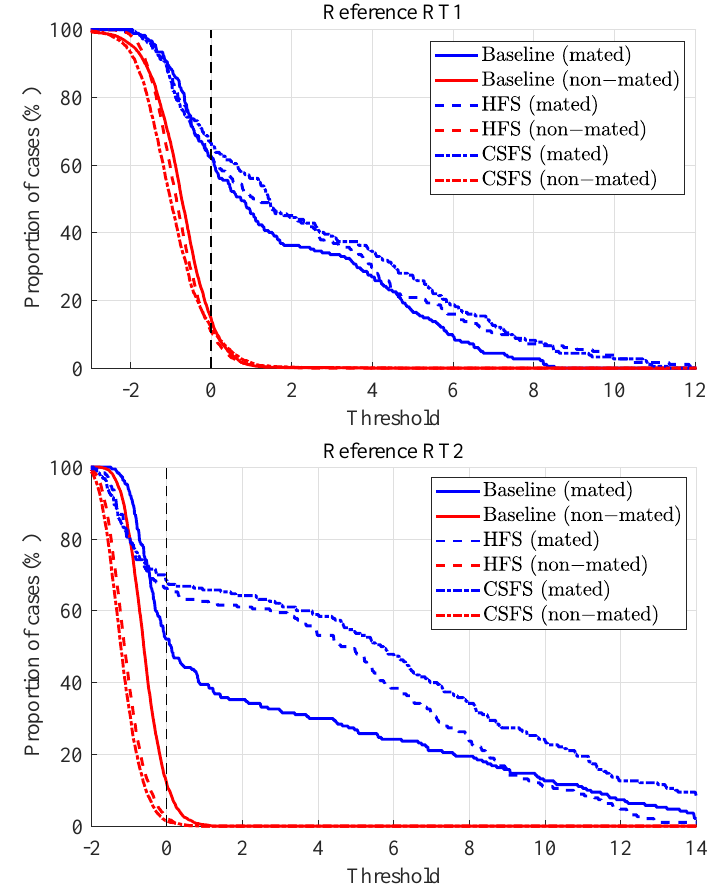
Figure 14. Tippett plots: stabilized videos vs. RT1 (upper) and RT2